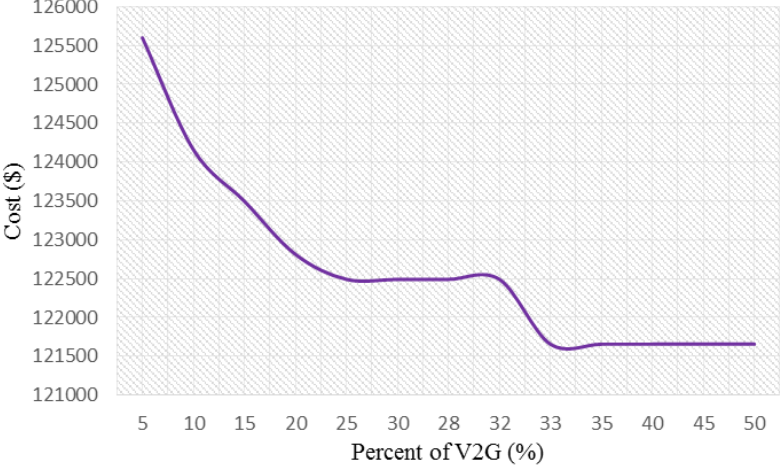
Figure 9. The operation cost of the grid for different degrees of EV penetration.